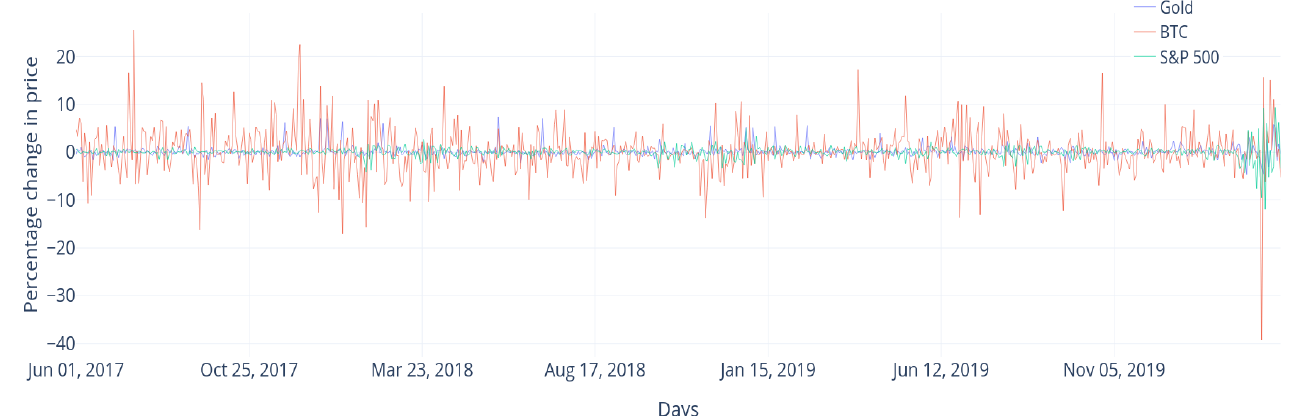
Figure 1. Percentage change in price vs. days for Bitcoin, gold, and the S&P